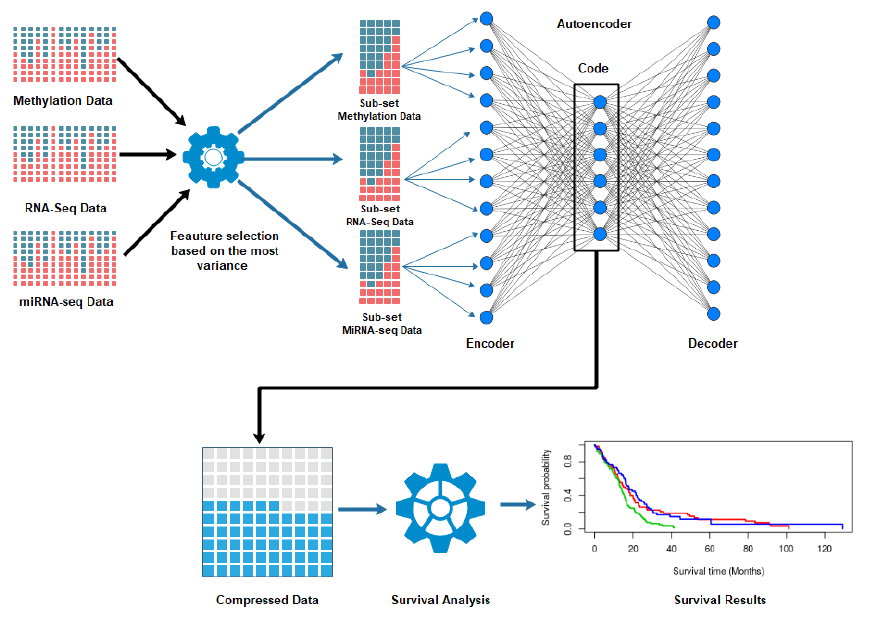
Figure 1. The workflow of subtype detection using autoencoders. First, we perform feature selection from the multi-omics data of the same patients from the TCGA database. Next, autoencoders fuse the selected features by encoding and decoding. Then, we run two clustering algorithms on the patient similarity networks constructed from the bottleneck layer to identify the subtypes of cancer. Finally, we run a survival analysis of the identified clusters to validate the